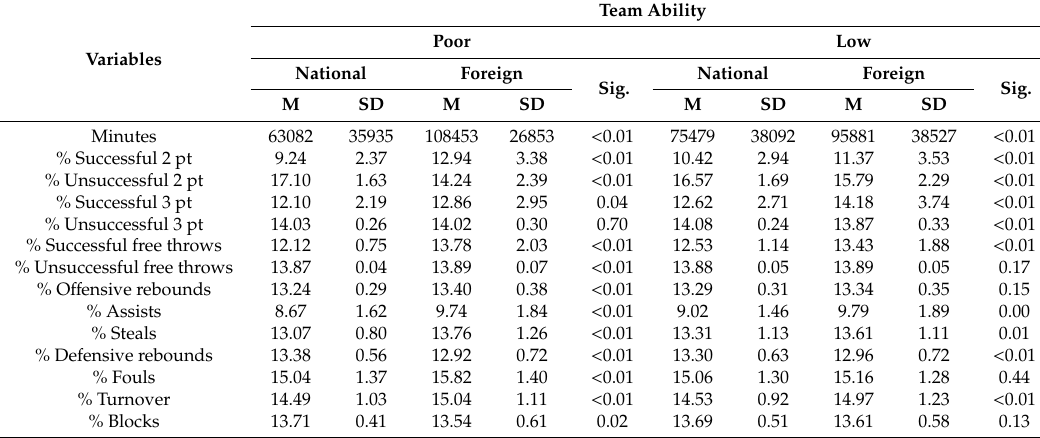
Table 1. Descriptive results (M, mean; SD, standard deviation) of national and foreign Guards based upon poor, low, medium, and high team